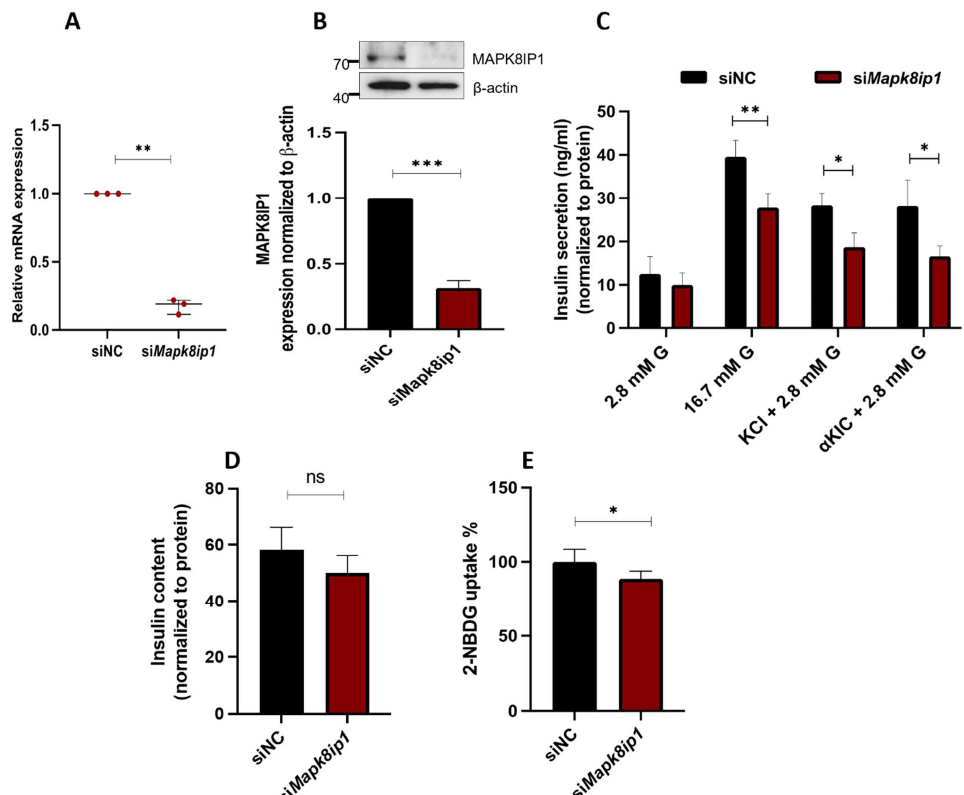
Figure 2. Silencing of Mapk8ip1 diminishes insulin secretion in INS-1 cells. Cells were transfected with siRNA against Mapk8ip1 ( siMapk8ip1 ) or the siRNA negative control (siNC). ( A ) The silencing efficiency of Mapk8ip1 was measured by qRT-PCR 48 h post-transfection. Data were obtained from three independent experiments. ( B ) Western blot expression analysis of MAPK8IP1 and β -actin (endogenous control) in INS-1 cells transfected with siRNA against Mapk8ip1 or the negative control (upper panel). Fold change in the intensity of the Western blot band of MAPK8IP1 protein relative to the endogenous control β -actin in Mapk8ip1 -silenced cells or negative control cells (lower panel). Data were obtained from three independent experiments. ( C ) Normalized stimulated insulin secretion in response to 2.8 mM glucose (2.8 mM G), 16.7 mM glucose (16.7 mM G), 35 mM KCl, or 10 mM α -KIC in the presence of 2.8 mM glucose in Mapk8ip1 -silenced cells or negative control cells for one static hour of incubation. Data were obtained from three independent experiments. ( D ) Insulin content measurements normalized to protein content in Mapk8ip1 -silenced cells compared to negative control cells. Data were obtained from three independent experiments. ( E ) Evaluation of glucose uptake efficiency in Mapk8ip1 -silenced cells compared to control cells. Data were obtained from three independent experiments. * p < 0.05, ** p < 0.01, *** p < 0.001 and ns; not significant. Bars represent mean ± SD. Statistical analyses were performed using Student t